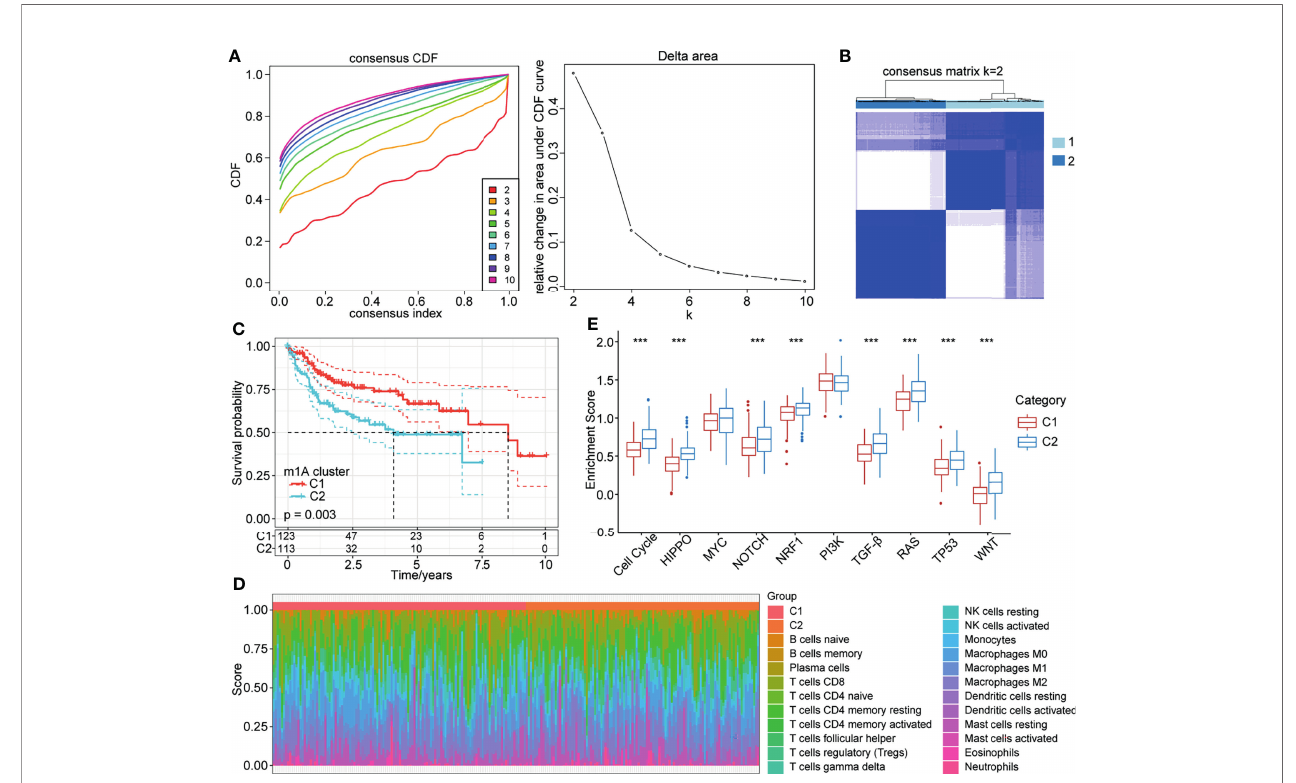
FIGURE 2 | m1A modi fi cation patterns mediated by 10 regulators. (A) CDF curve and CDF delta area curve in TCGA-LIHC cohort. (B) Clustering heatmap when consensus k=2. (C) Kaplan-Meier curve of the prognostic relationship between the two clusters in the TCGA-LIHC cohort. (D) Proportions of 22 immune cell components in samples in C1 and C2. (E) Differences in the scores of 10 pathways related to tumor abnormalities in C1 and C2. ***P <